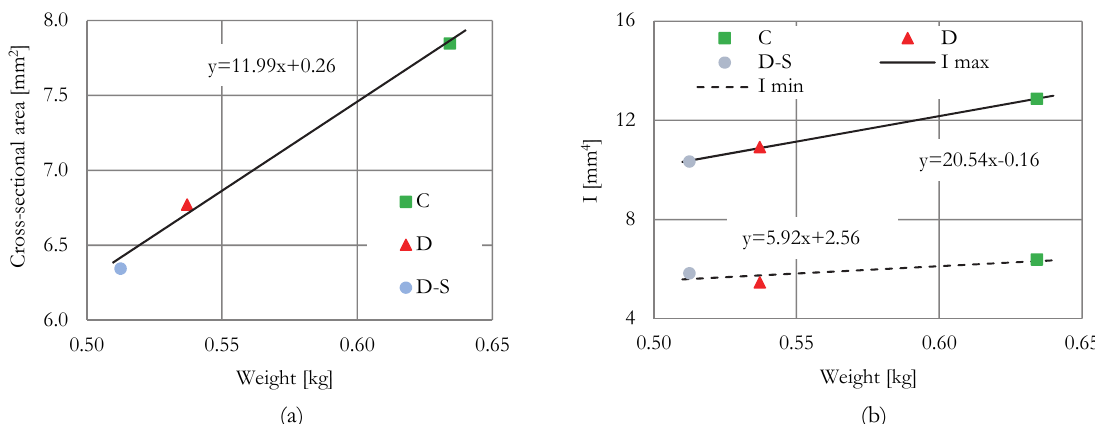
Figure 8: The average weight of the animals of the three groups versus the respective average value of (a) The femora’s cross-sectional area and (b) The femora’s principal second moments of